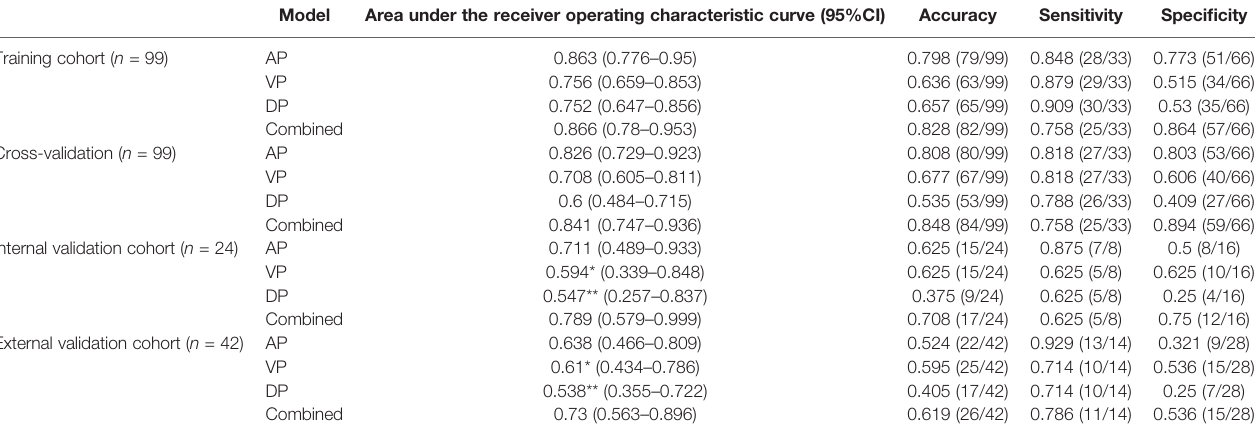
TABLE 2 | The detailed performance of arterial phase (AP) model, venous phase (VP) model, delayed phase (DP) model, and combined